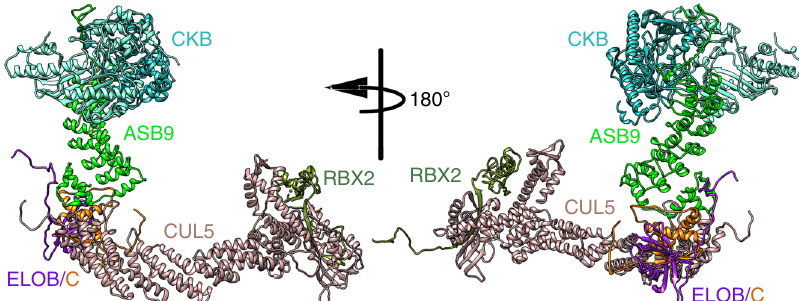
Fig. 3 Model of the full ASB9-CRL. A complete model of the un-activated ASB9-CRL was assembled from the cryo-EM model of CKB-ASB9-ELOB/C and the cryo-EM model of CUL5. The colors are as follows: CKB dimer (light sea green, aquamarine), ASB9 (green), ELOB/C (orange/purple), RBX2